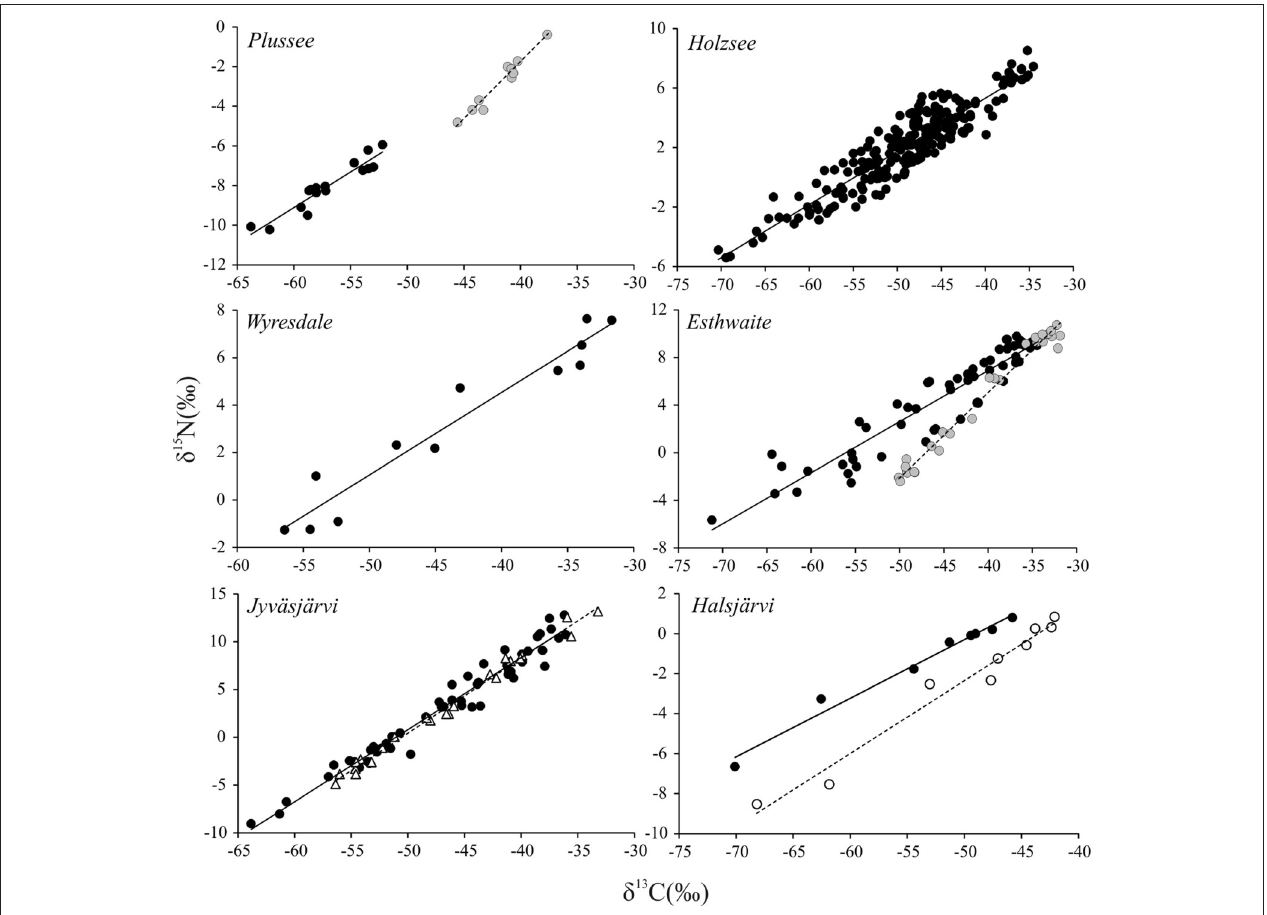
FIGURE 3 | Stable carbon and nitrogen isotope ratios of benthic chironomid larvae collected from stratifying lakes in Germany, England and Finland [data derived from Grey et al. (2004a), Deines et al. (2007a), Ravinet et al. (2010)]. Individuals were collected from a specific depth in each lake and on one date (except for Holzsee where the data are compiled from 12 sampling events in 1year). Species are Chironomus plumosus (filled black markers, solid line), Chironomus anthracinus (filled gray markers, dashed line), Propsilocerus jacuticus (Jyväsjärvi only; open triangle, dashed line), and Chironomus teniustylus (Halsjärvi only; open marker, dashed line). Lines are least squares regressions for illustrative purposes only.